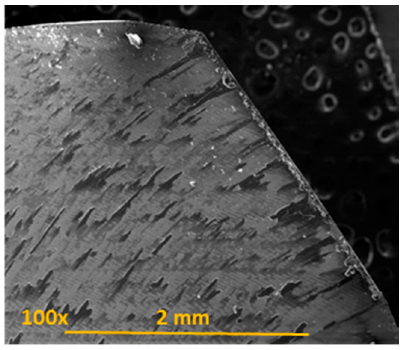
Figure 10. Increased bond wear with the number of holes.